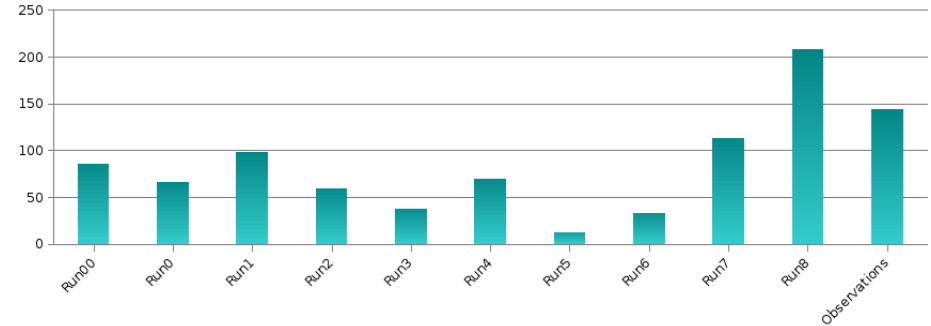
Fig. 15. Daily total precipitation (mm24h − 1 ) simulated and observed over Funchal on the 20 February. peak in the afternoon. The greatest discrepancies between model and observations are observed for Ponta do 18